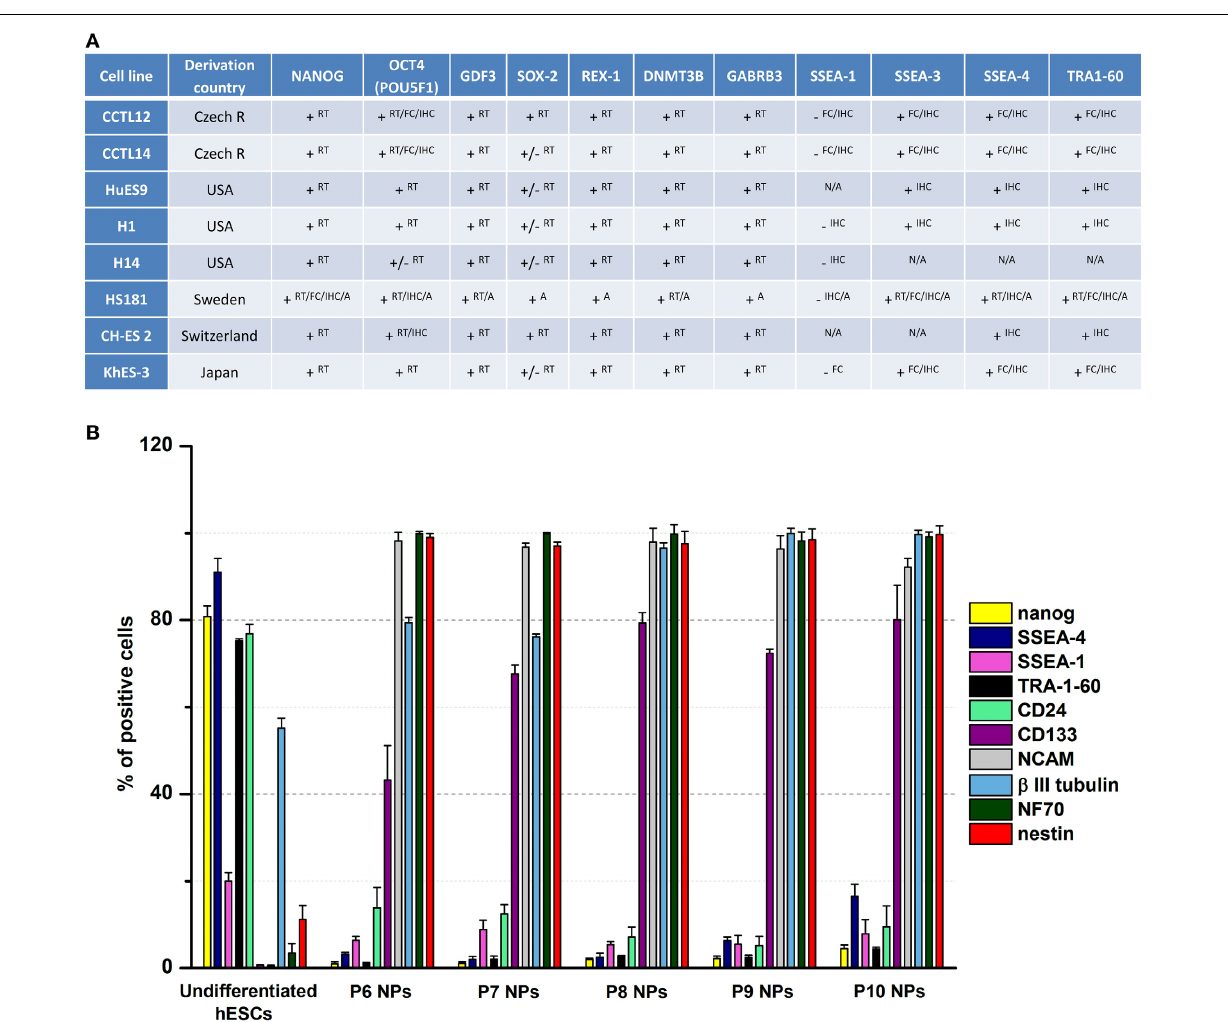
FIGURE 1 | Marker expression analysis. (A) This table summarizes the expression of characteristic markers in different lines of human embryonic stem cells. The data were taken from the European Human Pluripotent Stem Cell Registry. RT , RT-PCR; FC , Flow cytometry; IHC , Immunocytochemistry/ Immunohistochemistry; A , Array; + , detected; − , not detected; + / − , weak signal; N / A , not applicable. (B) Fluorescence-activated cell sorting profiles of